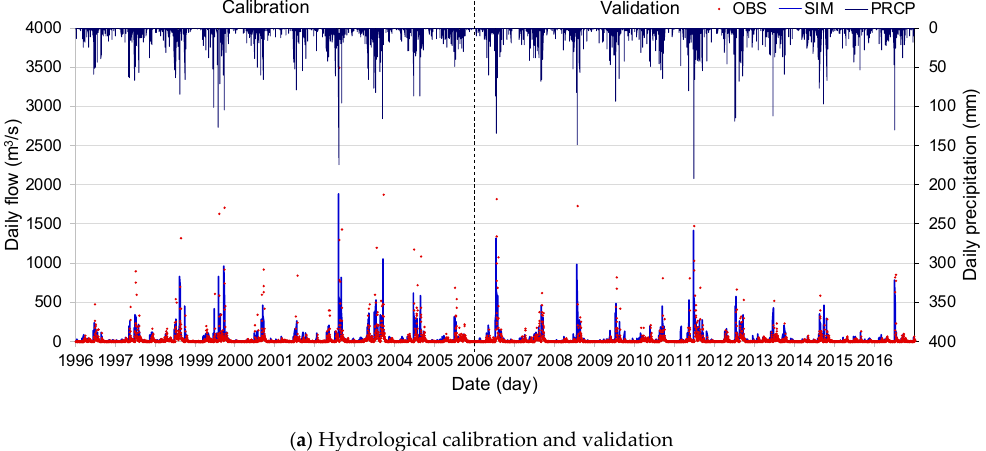
Table 5. Result of the HSPF model calibration and validation.